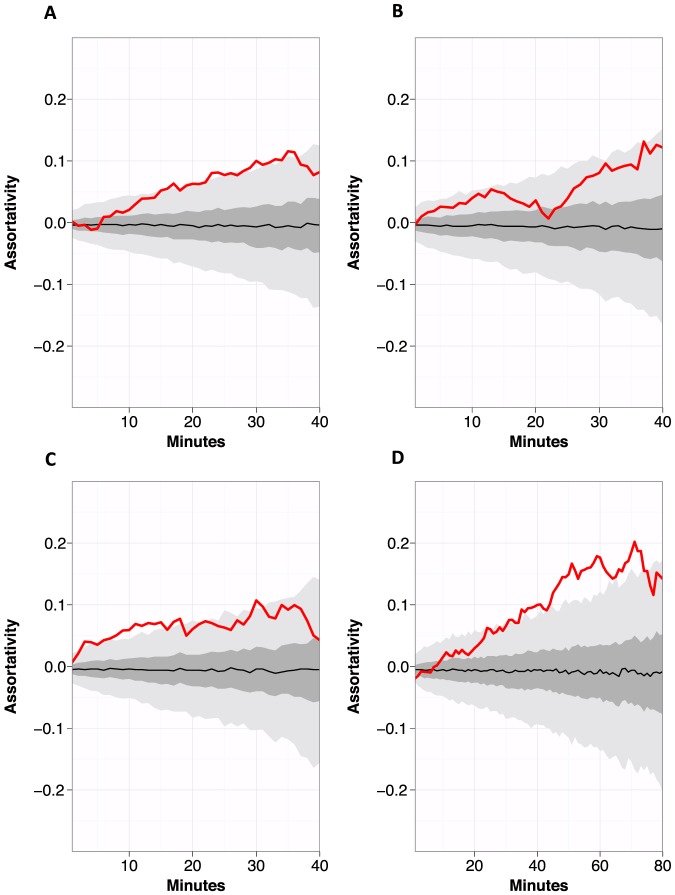
Calculated assortativity coefficient with respect to influenza vaccination status for a minimum contact duration in minutes: (A) on the first day of contact data collection; (B) on the second day of contact data collection; (C) on the third day of contact data collection; (D) on the combined contact data from days 1, 2, and 3.In each panel, the red line represents the assortativity coefficient of the measured network and the black line represents the median assortativity coefficient where vaccination status was randomly allocated to nodes in the network. The dark gray area covers the range from the first to the third quartile of the random networks. The light gray area covers the range from the 2.5 to the 97.5 percentile of the random networks.